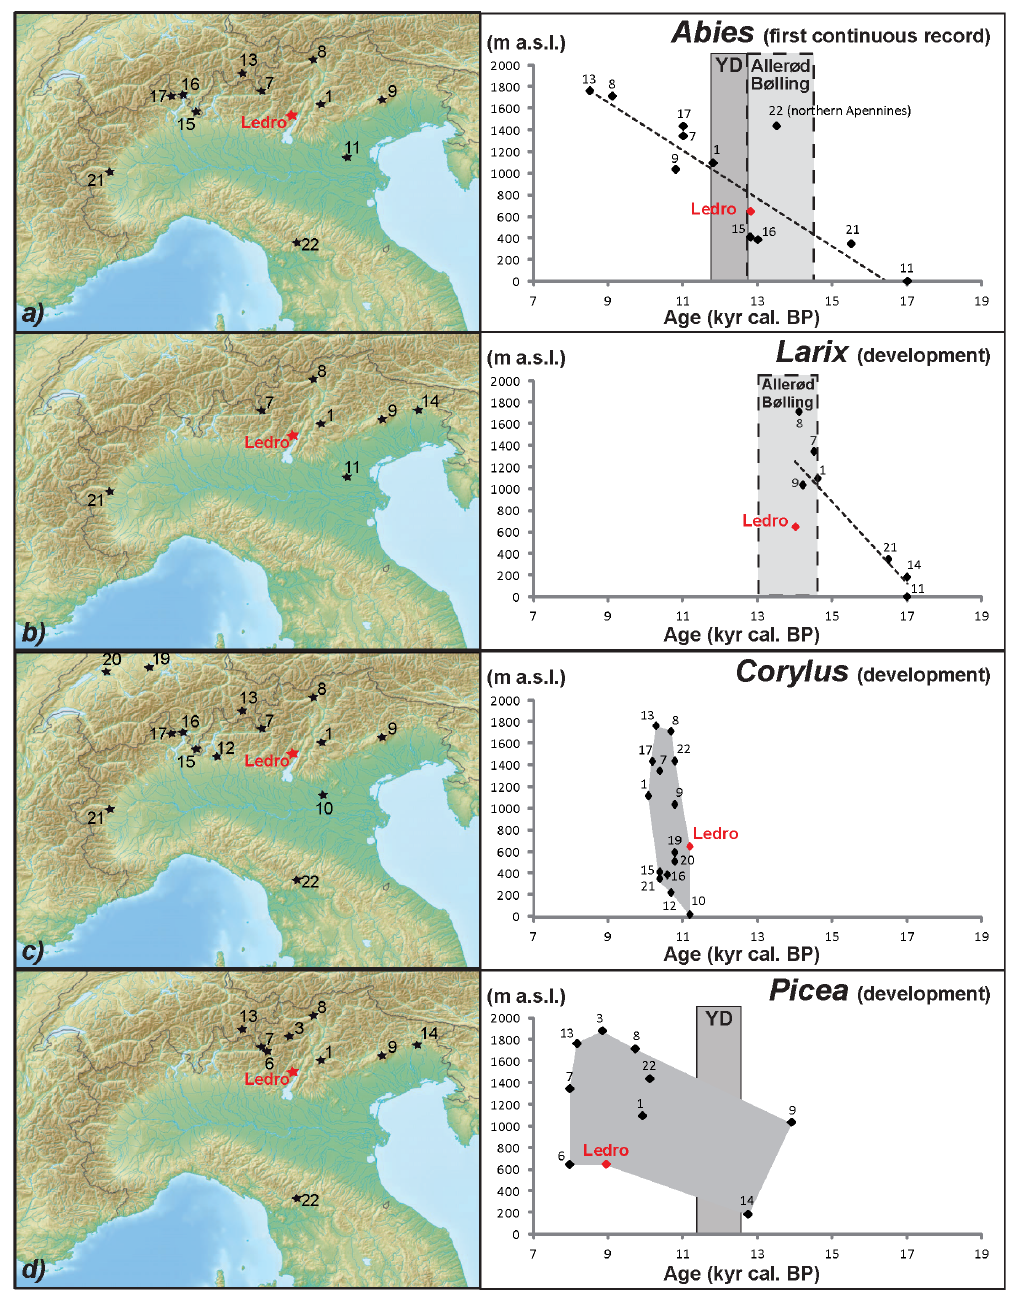
Fig. 6. Compilation of pollen records (plus macrofossil and stomata data when available) from the southern Alps and Switzerland and the northern Apennines. Location of sites and graphs are provided, where age estimates are plotted against altitude, for the four tree taxa Abies , Larix , Corylus and Picea . Site numbers refer to the caption from Fig. 1. (a) Ages of the first continuous Abies (fir) record; (b) , (c) and (d) ages for the development of Larix (larch), Corylus (hazel) and Picea (spruce). YD=Younger